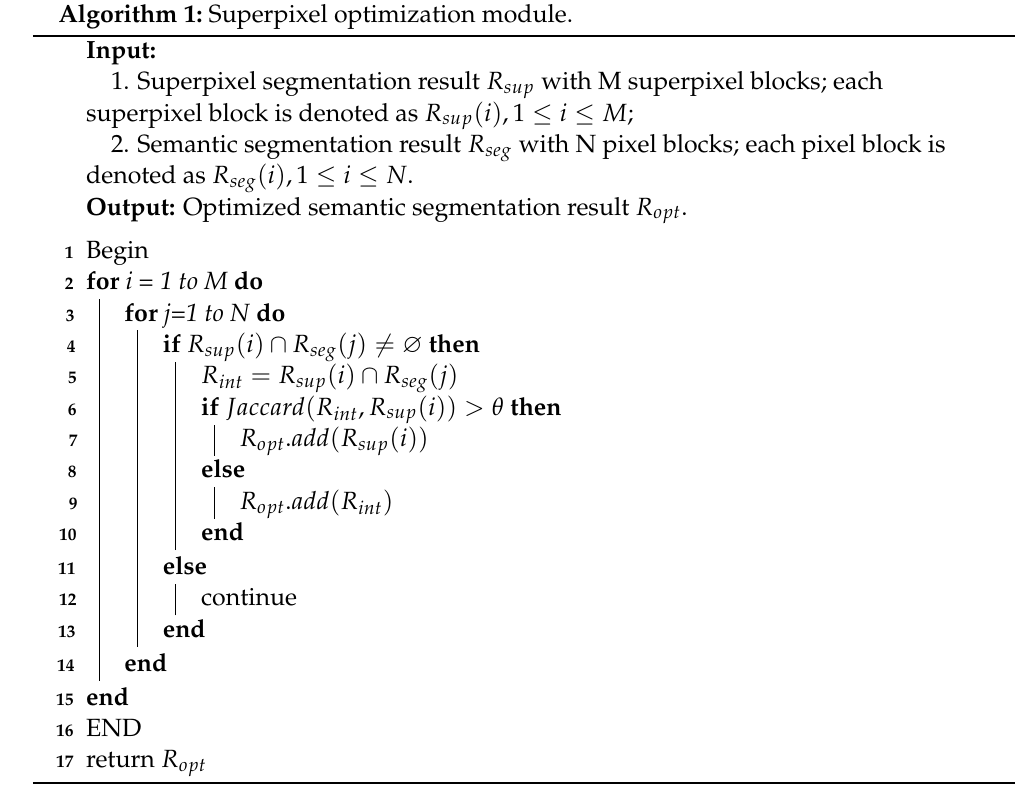
Algorithm 1: Superpixel optimization